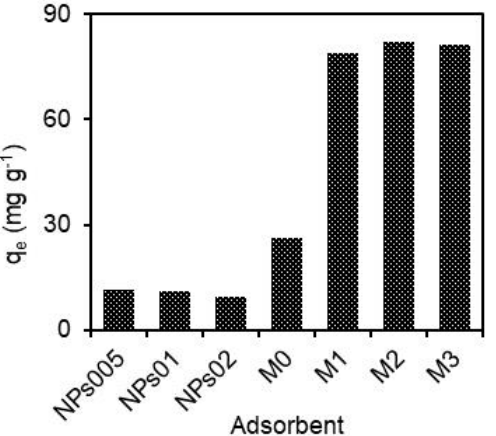
Figure 1. Adsorption capacity of hydRB5 with a concentration of 100 mg L − 1 for prepared adsorbents, in pH = 7 and 25 ± 0.5 ◦